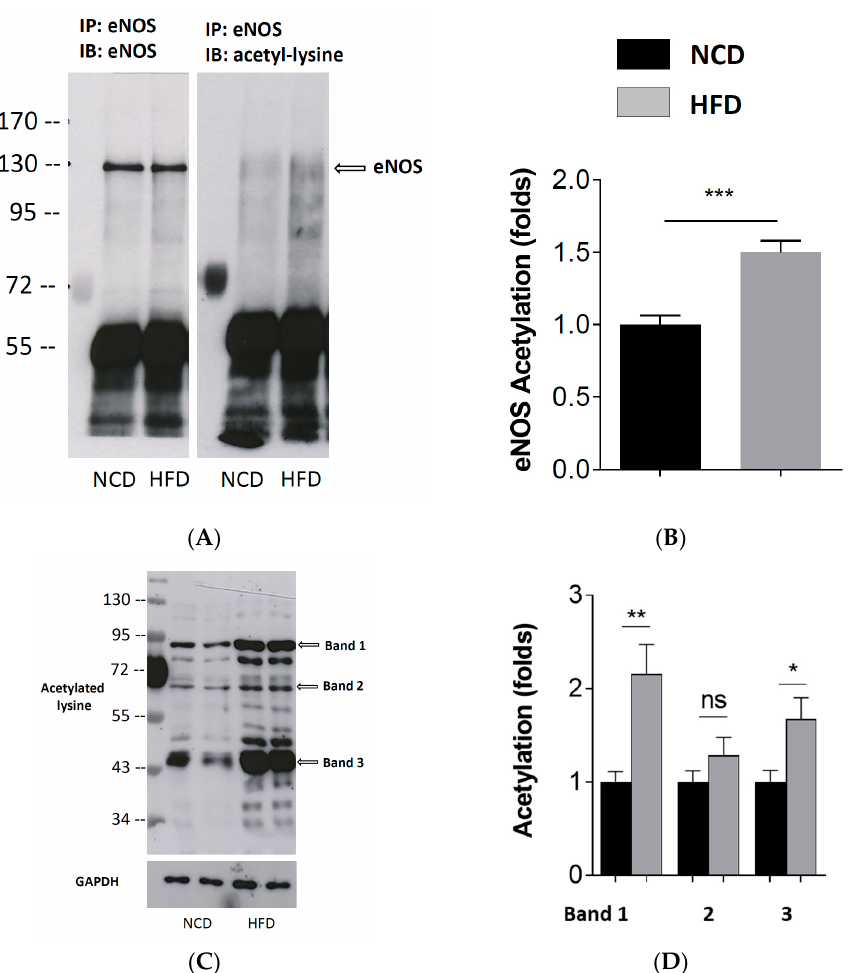
Figure 4. Enhanced eNOS acetylation in PVAT of diet-induced obese mice. Male C57BL/6J mice were treated with NCD or HFD for 20 weeks. eNOS immunoprecipitation (IP) was performed with the PVAT samples using an eNOS antibody. Immunoblotting (IB) was performed with the eNOS IP product using an antibody against eNOS and an antibody against acetyl-lysine, respectively. The band detected with the antibody against acetyl-lysine at the level of eNOS was considered acetyl- eNOS. The blots shown ( A ) are representative of 3 independent experiments with similar results. Results of densitometric analyses for the acetyl-eNOS normalized to a total eNOS are shown in ( B ). Columns represent mean ± SEM. *** p < 0.001, n = 6. In separate experiments, Western blot analyses (WB) were performed with an antibody against acetyl-lysine using the PVAT samples without IP. The blots shown ( C ) are representative of 3 independent experiments with similar results. The results of densitometric analyses for acetylated proteins normalized to GAPDH are shown in ( D ). Columns represent mean ± SEM. ns, not significant; * p < 0.05, ** p < 0.01, n =